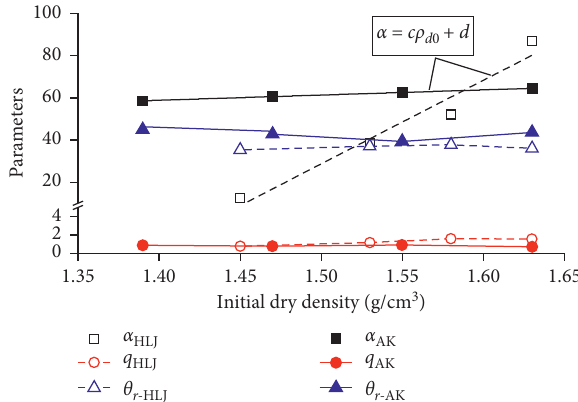
Figure 10: Relationships between parameters of Gardner model and the initial dry density for HLJ